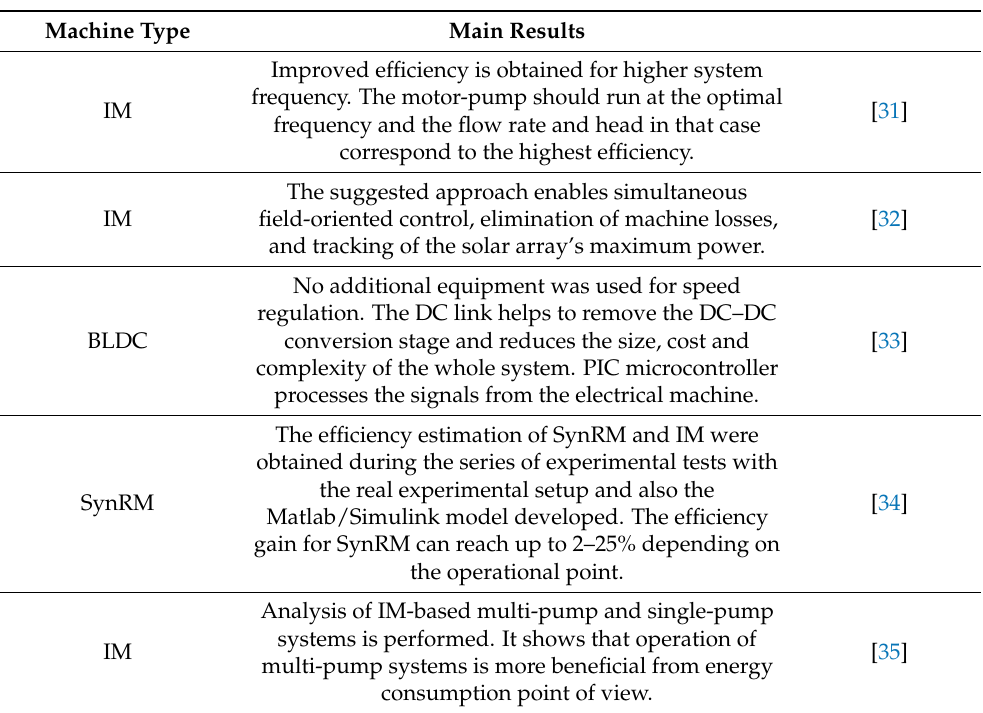
Table 4. Application of different electrical machines in solar- and grid-powered pumping systems. Machine